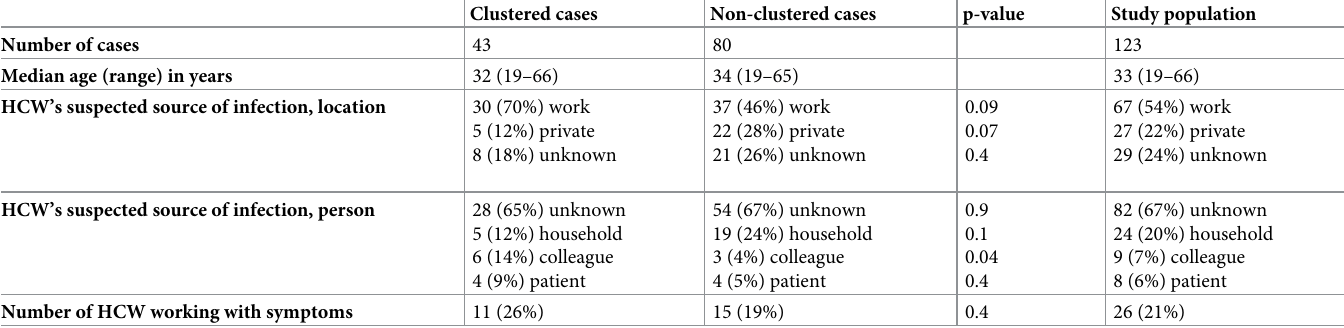
Table 1. Characteristics of clustered cases, non-clustered cases and study population (clustered and non-clustered combined). Clustered cases Non-clustered